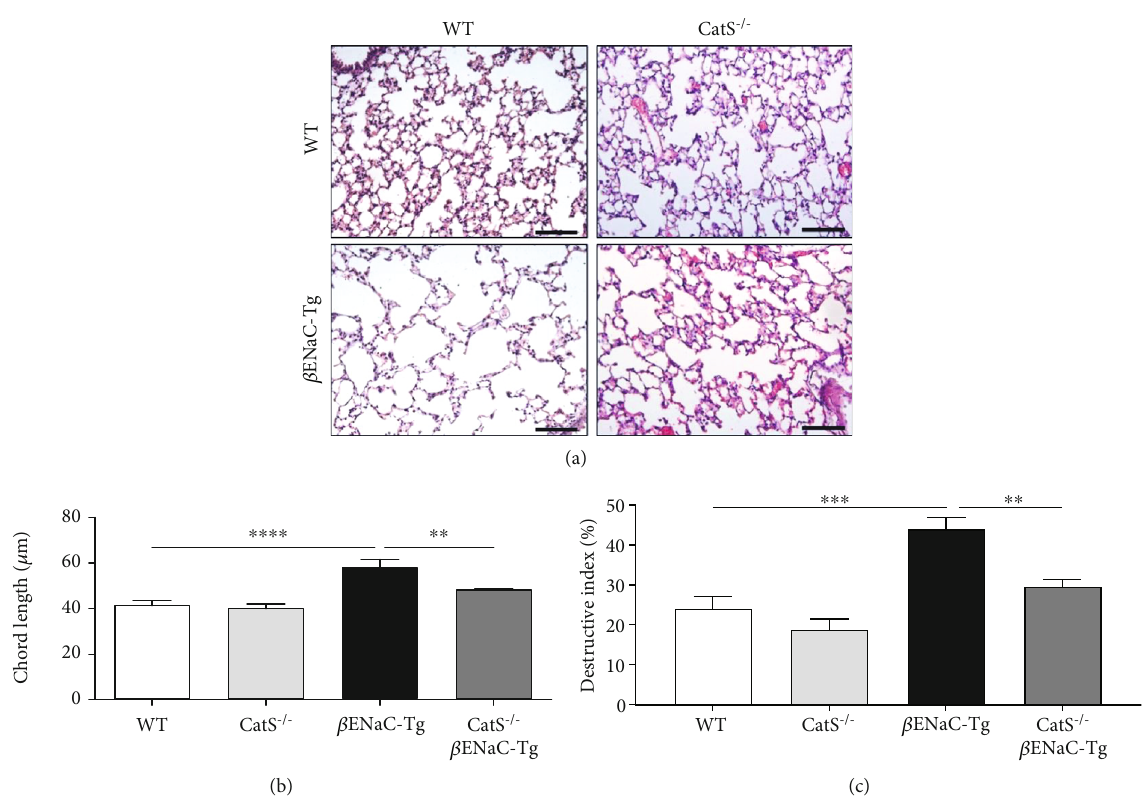
Figure 4: Cathepsin S knockdown from birth limits lung tissue destruction. (a) Representative images of lung sections stained with haematoxylin and eosin (H&E) used to assess airway damage. Scale bar = 100 μ m . (b) Mean linear intercept and (c) destructive index measurements were quanti fi ed from H&E-stained lung sections as detailed in materials and methods ( n = 5 ‐ 6 per group). ∗∗ P < 0 : 01 , ∗∗∗ P < 0 : 001 , ∗∗∗∗ P < 0 : 0001 (one-way ANOVA with Tukey ’ s multiple comparisons